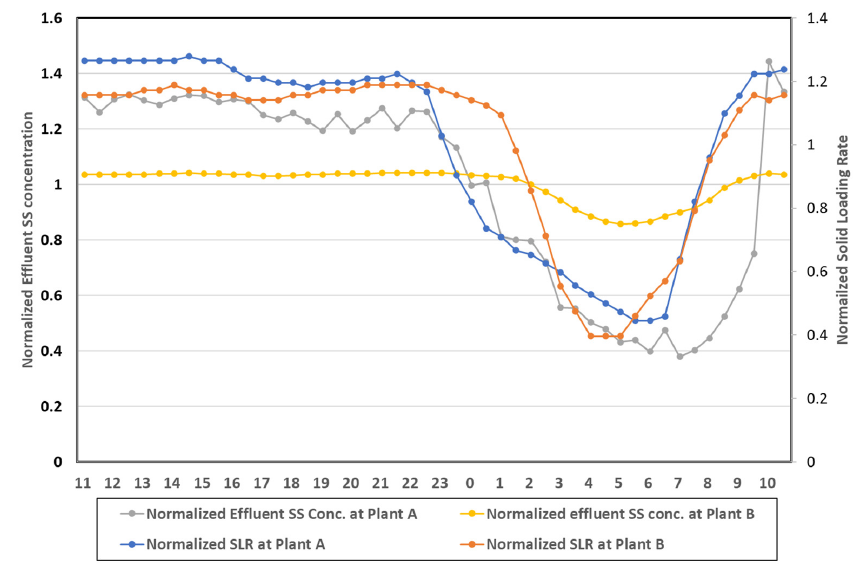
Figure 10. Normalized hourly effluent SS concentrations and SLRs at Plants A and B.